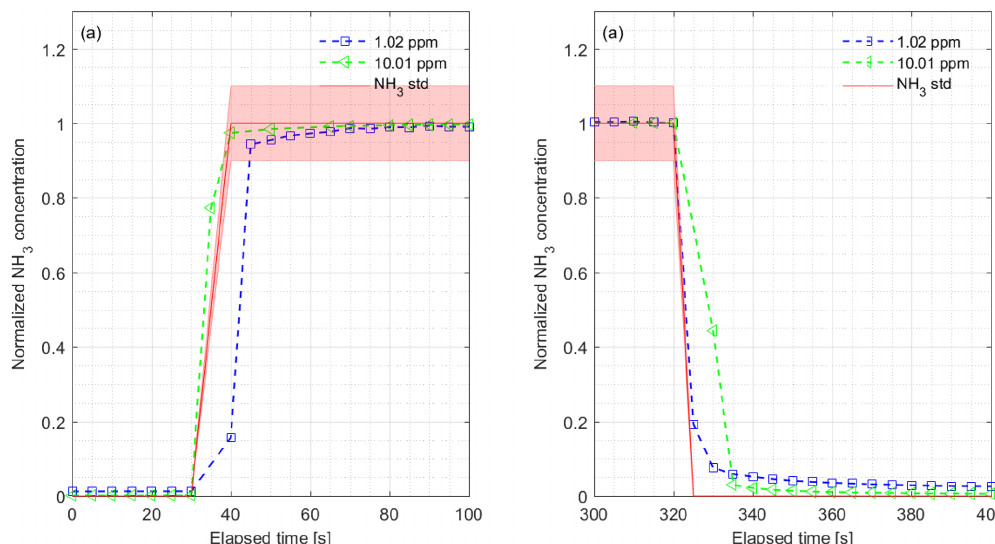
Figure 3. (a) Rise time and (b) fall time for the CRDS measurements normalized to final concentrations during laboratory testing of the response to a step change to 1.02 (blue) and 10.01ppm (green). The results show NH 3 to 1.02ppm with rise time ( 1 /e) = 8 . 1s and fall time ( 1 /e) = 3 . 2s and 10.01ppm with rise time = 3.6s and fall time = 4.8s. The red lines and areas represent the NH 3 standard gas concentra- tion with 10% accuracy, the blue markers show the normalized concentration from 1.02ppm and the green markers show the normalized concentration from 10.01ppm.